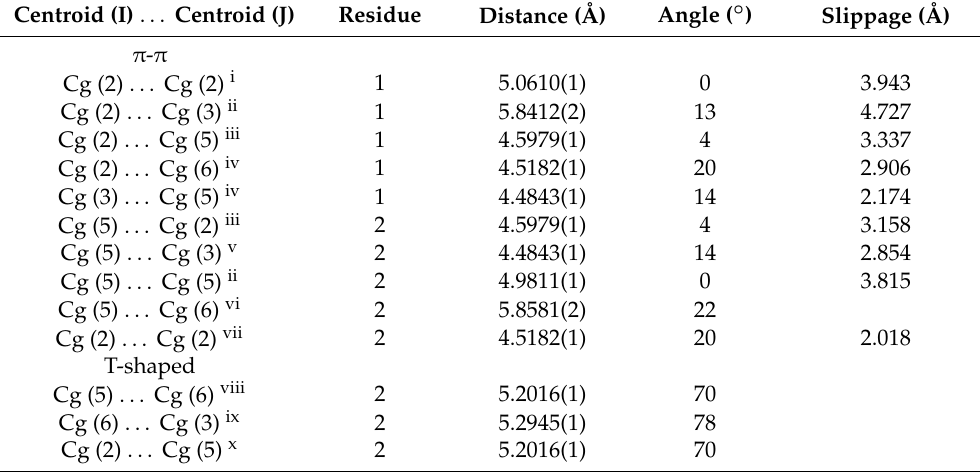
Table 4. Selected π - π -stacking and T-shaped non-covalent interactions between aromatic rings in 3 . Residues are the collection of Asymmetric Residue Units (ARUs) constituting an isolated unit. Distances between adjacent centroids (Cg) are measured in Å while dihedral angles between average planes passing from each considered ring are measured in ( ◦ ). Calculations cut-offs were set to Cg–Cg distances <6.0 Å and angles <20 ◦ (the latter for π - π